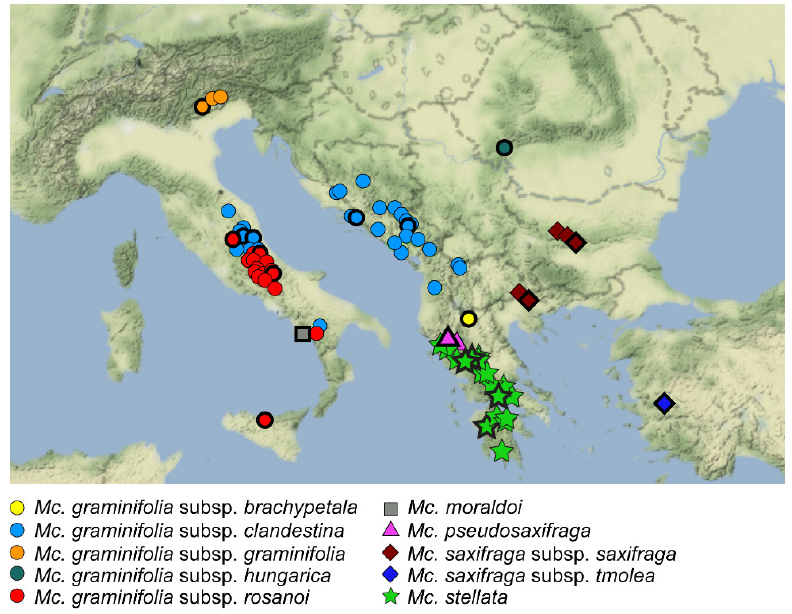
Figure 1. Distribution of the species and subspecies of Mcneillia . Symbols marked with a thick black line indicate the localities sampled in the present study.